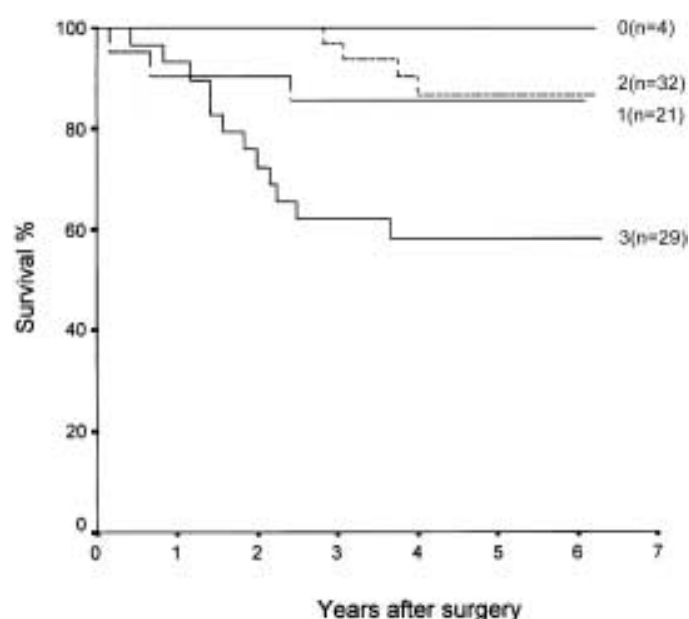
Fig. 2. Kaplan–Meier survival curve for 86 patients with colon adenocarcinoma related to the laminin-5 γ 2 chain expression 0–3 (log rank test: p = 0 .